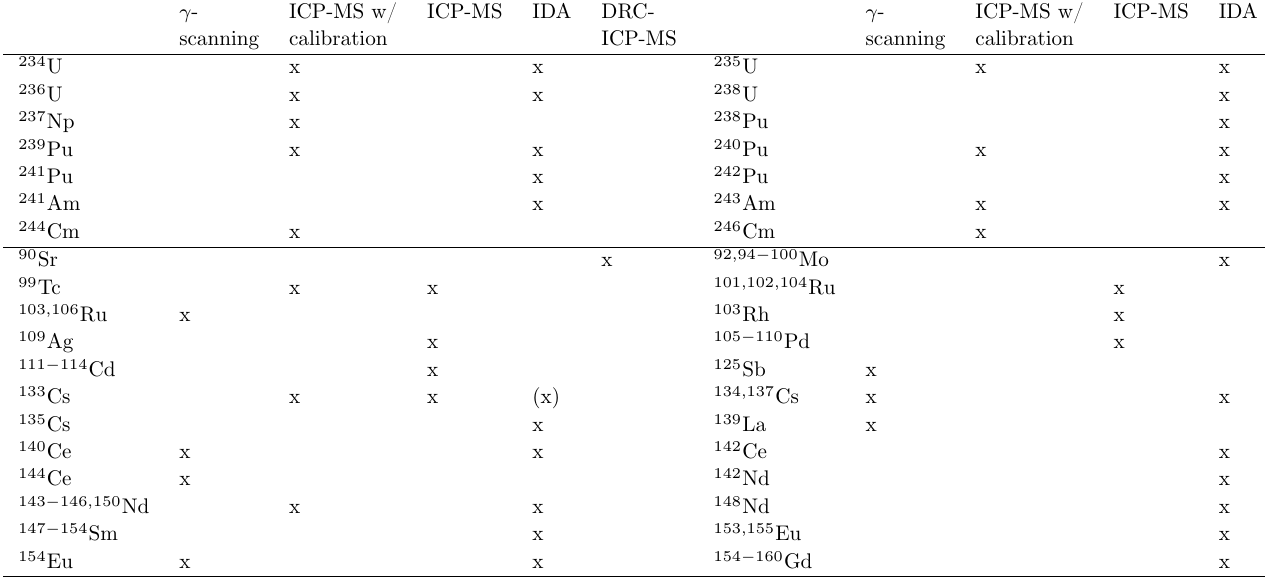
Table 3. List of measurement methods for each isotope. See text for